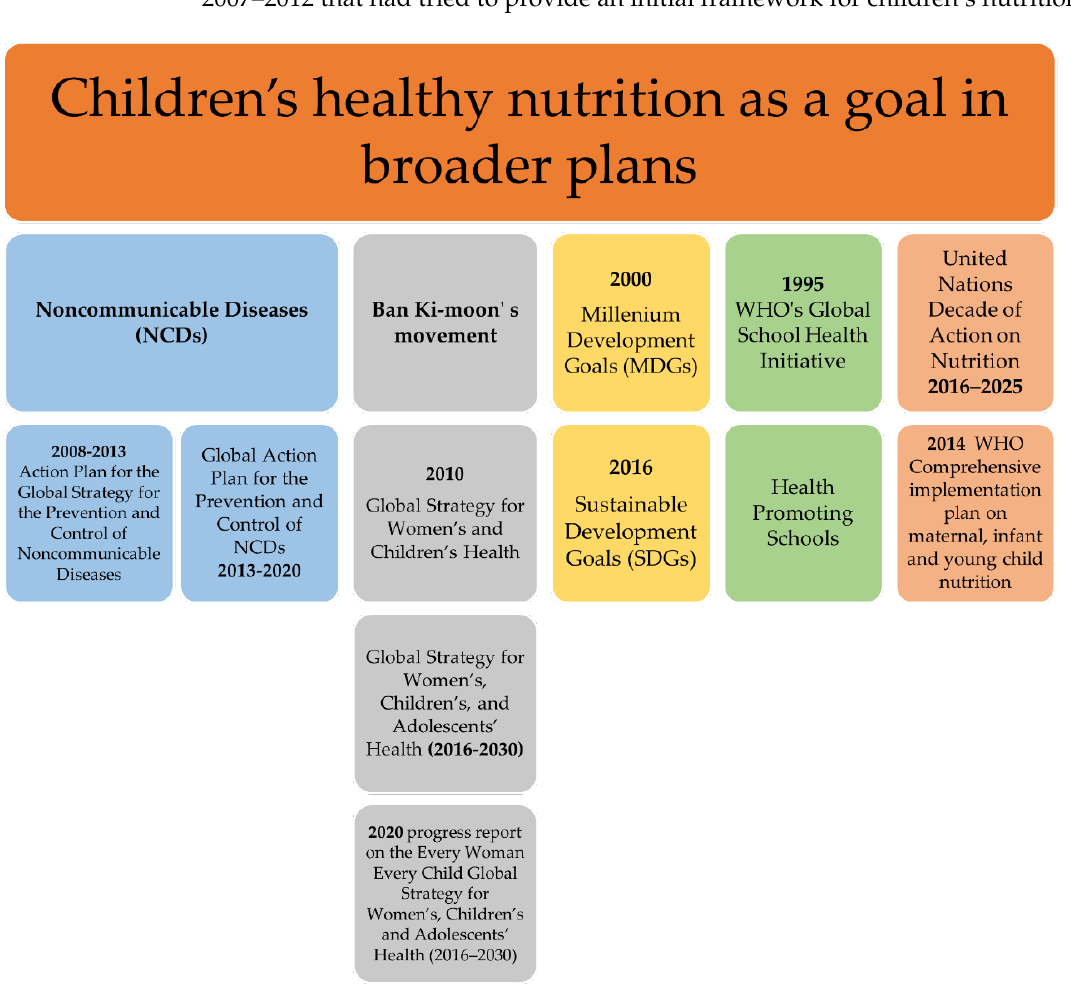
Figure 2. Children’s healthy nutrition as a goal in broader plans.